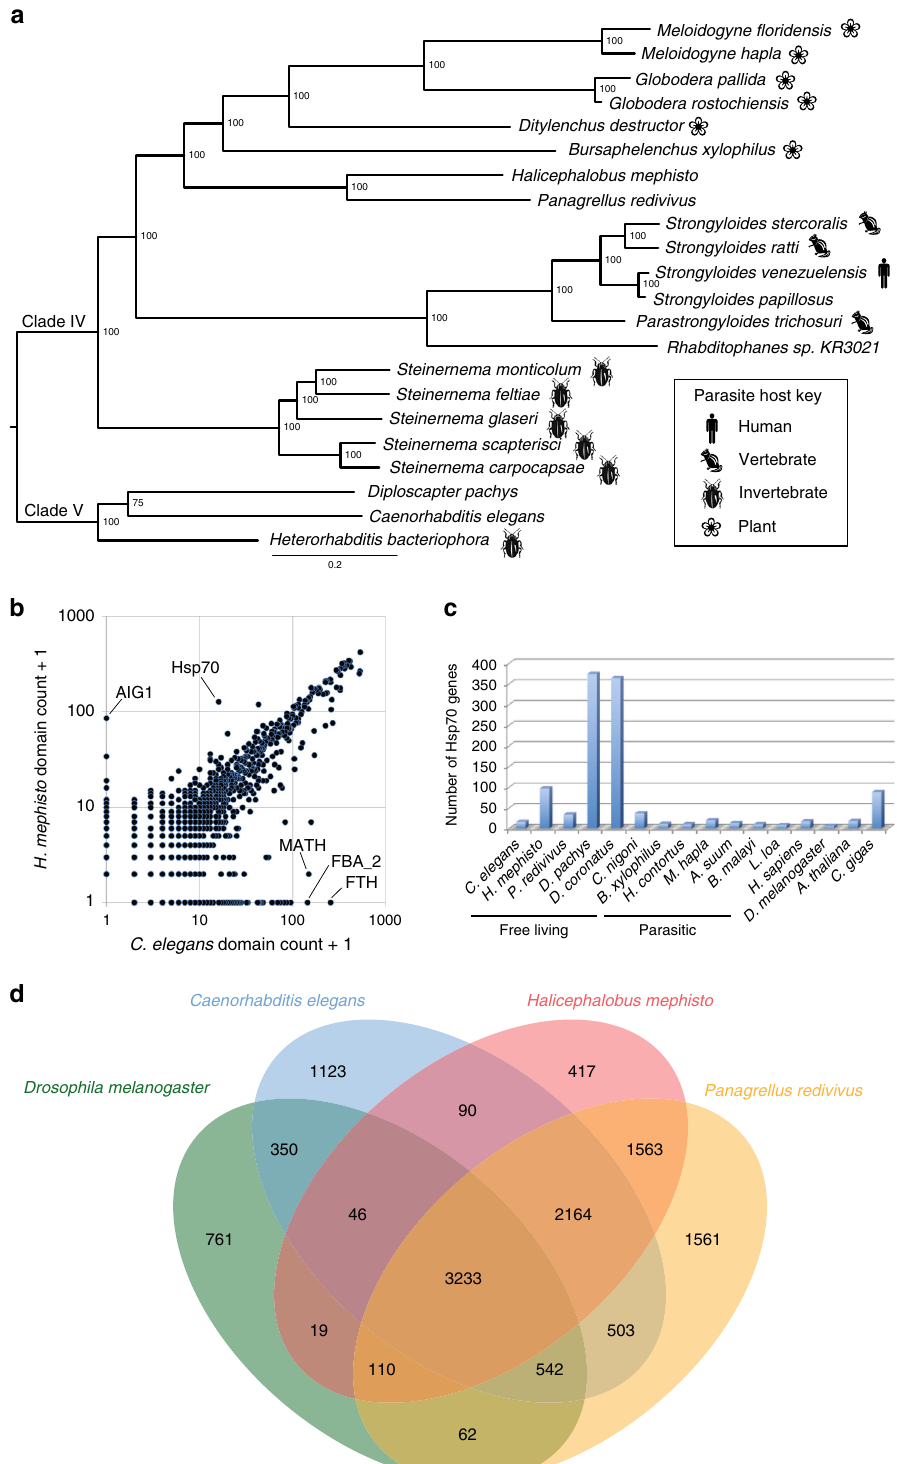
Fig. 1 Genomic comparison of H. mephisto protein-coding genes. a Multilocus phylogeny of H. mephisto using 99 single-copy orthologous genes (SCOGS). b Pfam domain comparison of nonredunant protein domain content in C. elegans versus H. mephisto at an e-value cutoff of 1e-10. Expanded AIG1 and Hsp70 domain families are marked, along with the MATH, FTH, and FBA_2 domains known C. elegans -speci fi c expansions. c Examination of Hsp70 family expansion across species, quantifying proteins, not domains, identi fi ed using e-values as in ( b ). d Venn diagram comparing orthologous gene clusters between D. melanogaster, C. elegans , P. redivivus , and H. mephisto . Abbreviations : MATH meprin and TRAF-homology domain, FTH Fog-2 homology